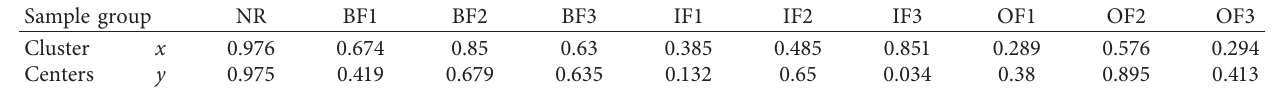
Table 3: Cluster centers of 10 types of